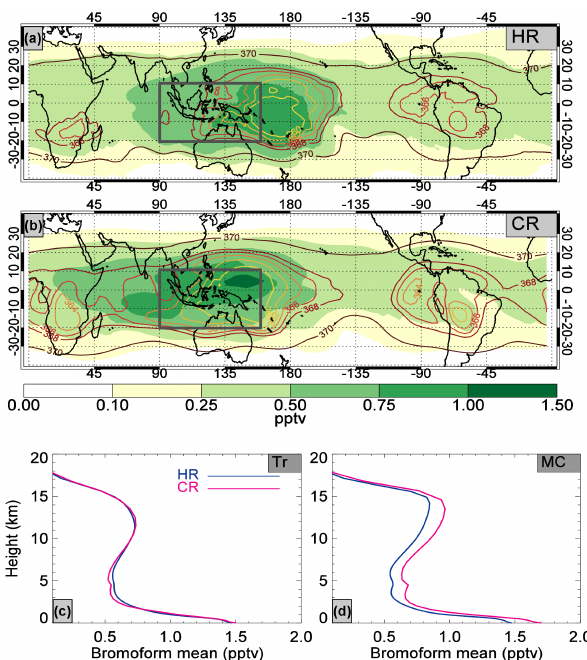
Figure 4. The monthly average mixing ratios for the Uniform tracer at 15.7km in February 2005 are shown for (a) the high-resolution run; and (b) the coarse-resolution run. Contours of monthly av- erage potential temperature are shown in (a) and (b) . Average vertical profiles of the mixing ratios for the two runs are shown for (c) the Tropics (20 ◦ S–20 ◦ N) and (d) the Maritime Continent (20 ◦ S–10 ◦ N; 90–160 ◦ E). High-resolution run is shown in blue; the coarse-resolution run is shown in pink.